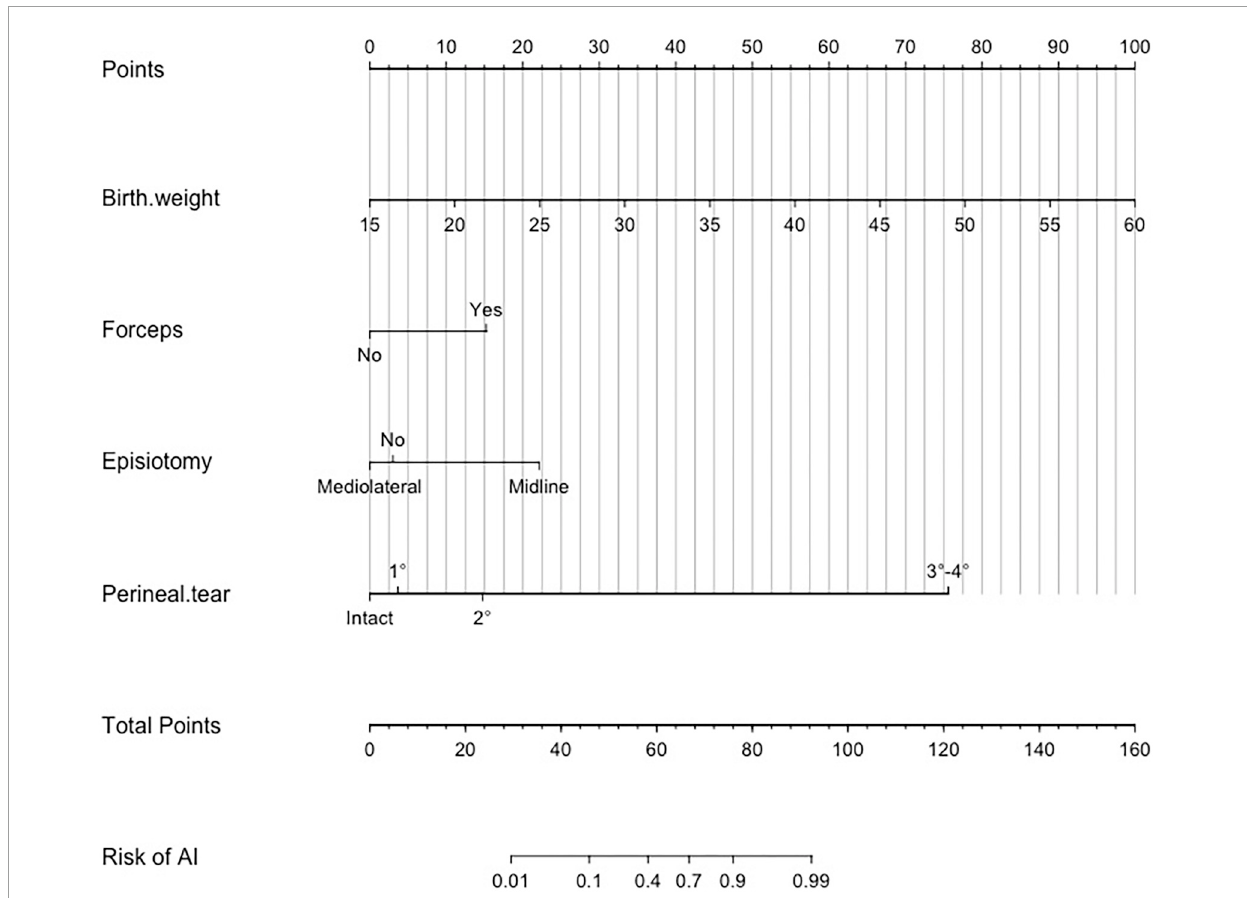
FIGURE3 Nomogram to estimate the risk of anal incontinence (AI) 1 year after vaginal delivery. To use the nomogram, find the position of each variable on the corresponding axis, draw a line to the points axis for the number of points, add the points from all of the variables, and draw a line from the total points axis to determine the AI probabilities at the lower line of the nomogram. The unit of birth weight is 100 g. For example, if a woman had a fetal birth weight of 2,700 g, underwent forceps delivery, received mediolateral episiotomy, and had second-degree perineal tear, the point values for each of these risk factors would be 28, 15, 0, and 15, respectively. The total points were 58, which corresponded to a 40% risk of postpartum